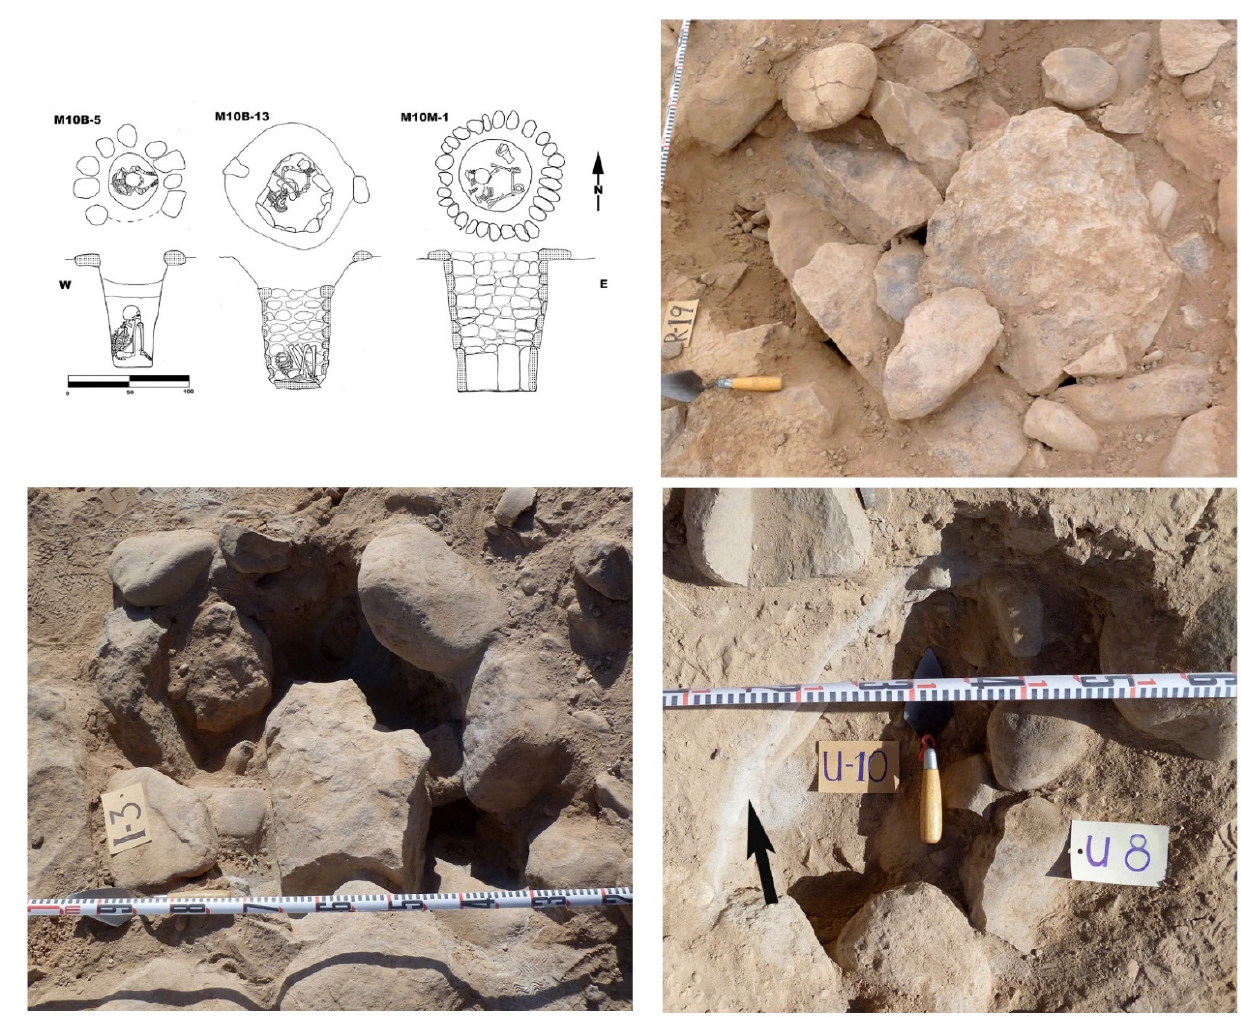
Figure 6. Top left , diagram of cist tomb view from above and cross section; modified from [45]; top right , Omo cemetery tomb with intact capstone; bottom left , collapsed rock capstone of an Omo cist tomb; bottom right , Omo cemetery collared tomb on the left (U10) and radiocarbon dated pit (U8) next to tomb. Arrow is pointing to volcanic tephra from the February 1600 eruption of the Huaynaputina volcano. Note the openings allowing infill sediment and creating a burrow for animals. (photos by Sarah I. Baitzel).